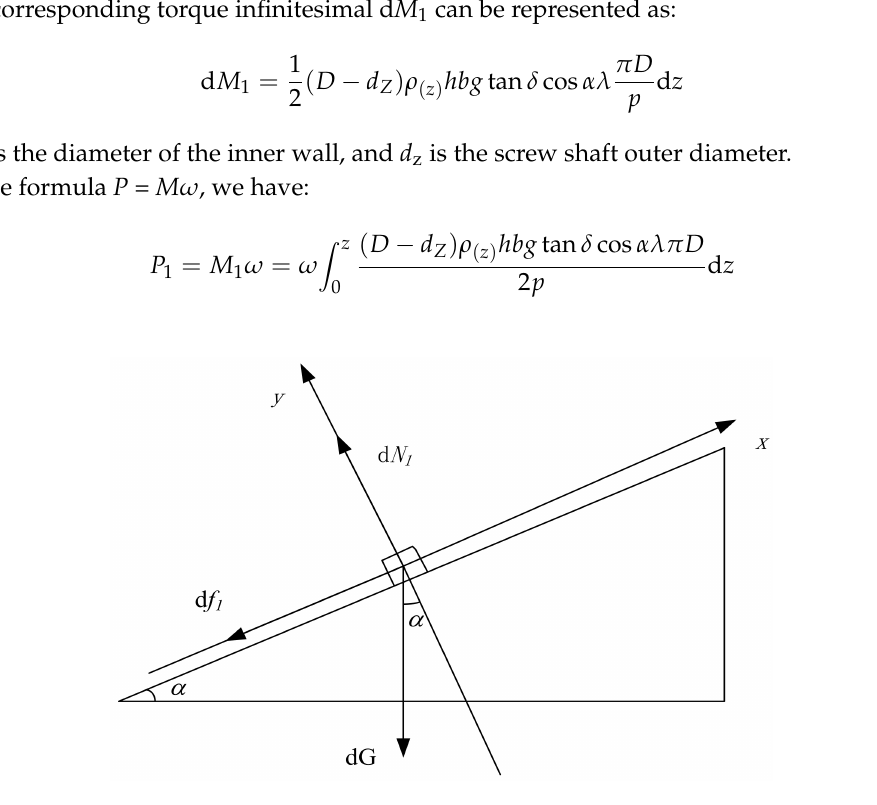
Figure 6. Diagram of the stress of the material along the spiral surface.